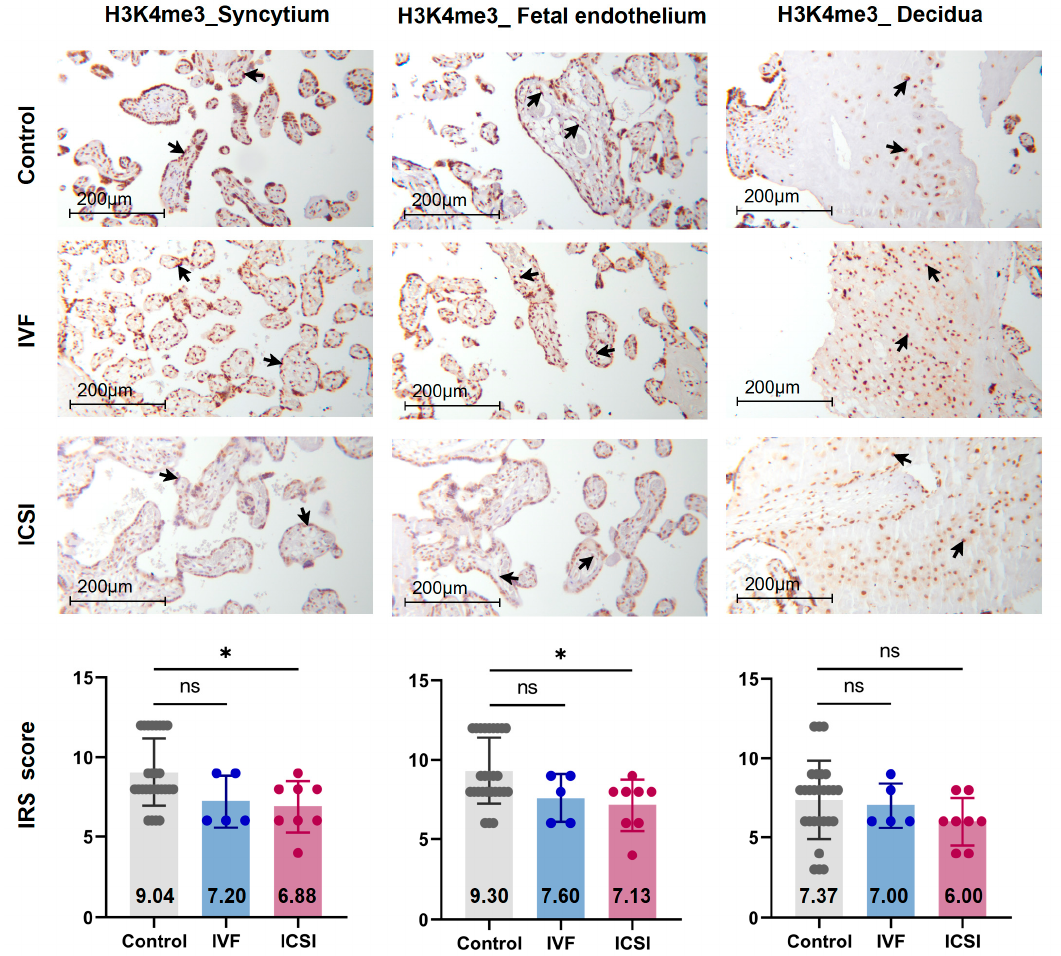
Figure 2. Global H3K4me3 was reduced in ICSI-derived placentas. Compared with natural conception placentas, ICSI placentas showed lower levels of H3K4me3 in syncytium and fetal endothelium, while IVF placentas showed no significant difference. Boxplots showing the IRS distribution among natural conception ( n = 27), IVF ( n = 5), ICSI ( n = 8) groups along with significance levels indicated as p -value of the Mann-Whitney U -test. IRS = staining intensity × percentage of positive cells. Data were reported as mean ± SD. The arrows in the first, second, and third columns respectively pointed towards syncytial trophoblast cells, foetal endothelial cells and extravillous trophoblast cells. The numbers inside the columns represented the mean value of the corresponding IRS. IRS, immunoreactivity score; ns, non-significant. * p < 0.05.